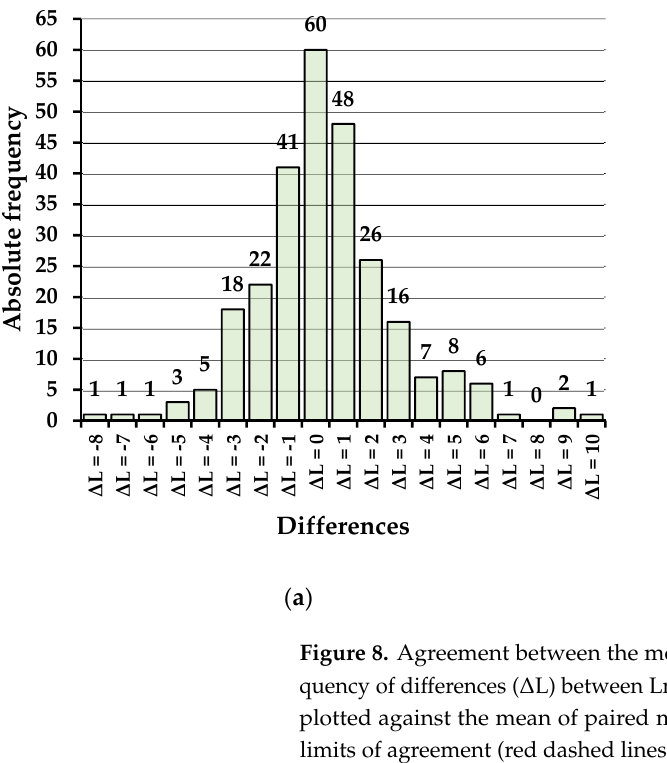
Figure 7. Relation between the diameters measured by the two methods (E1). Legend: red dashed line stands for perfect agreement and the green dashed line stands for the dependence relation between Dmeas and Dman fitted by RTO.